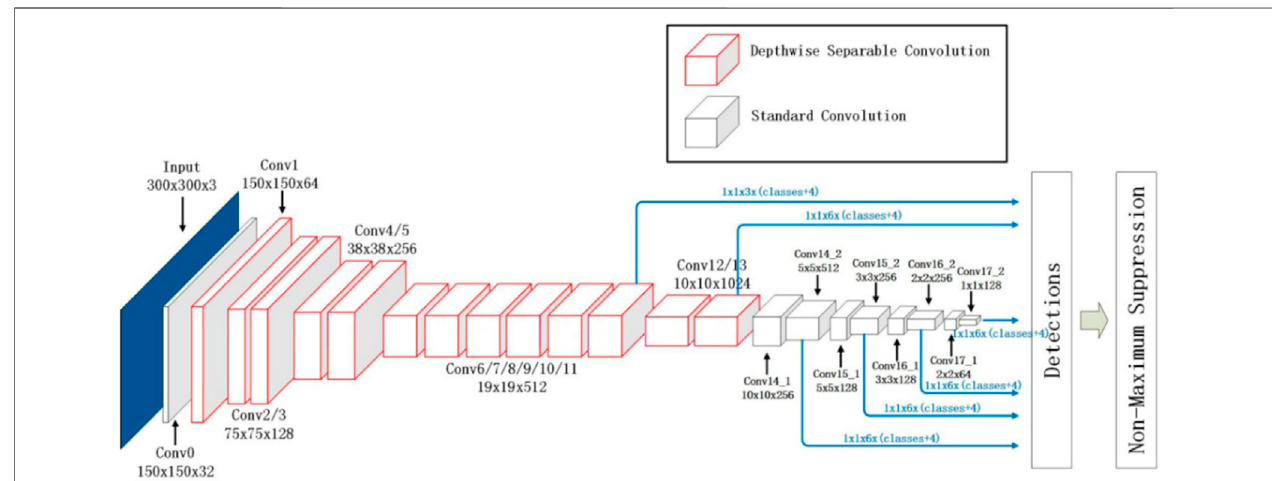
FIGURE 2 | MobileNet-SSD network